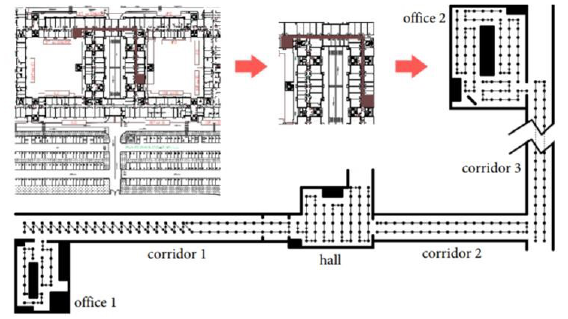
Figure 4. Trace generation environment for the Pisa traces [12].